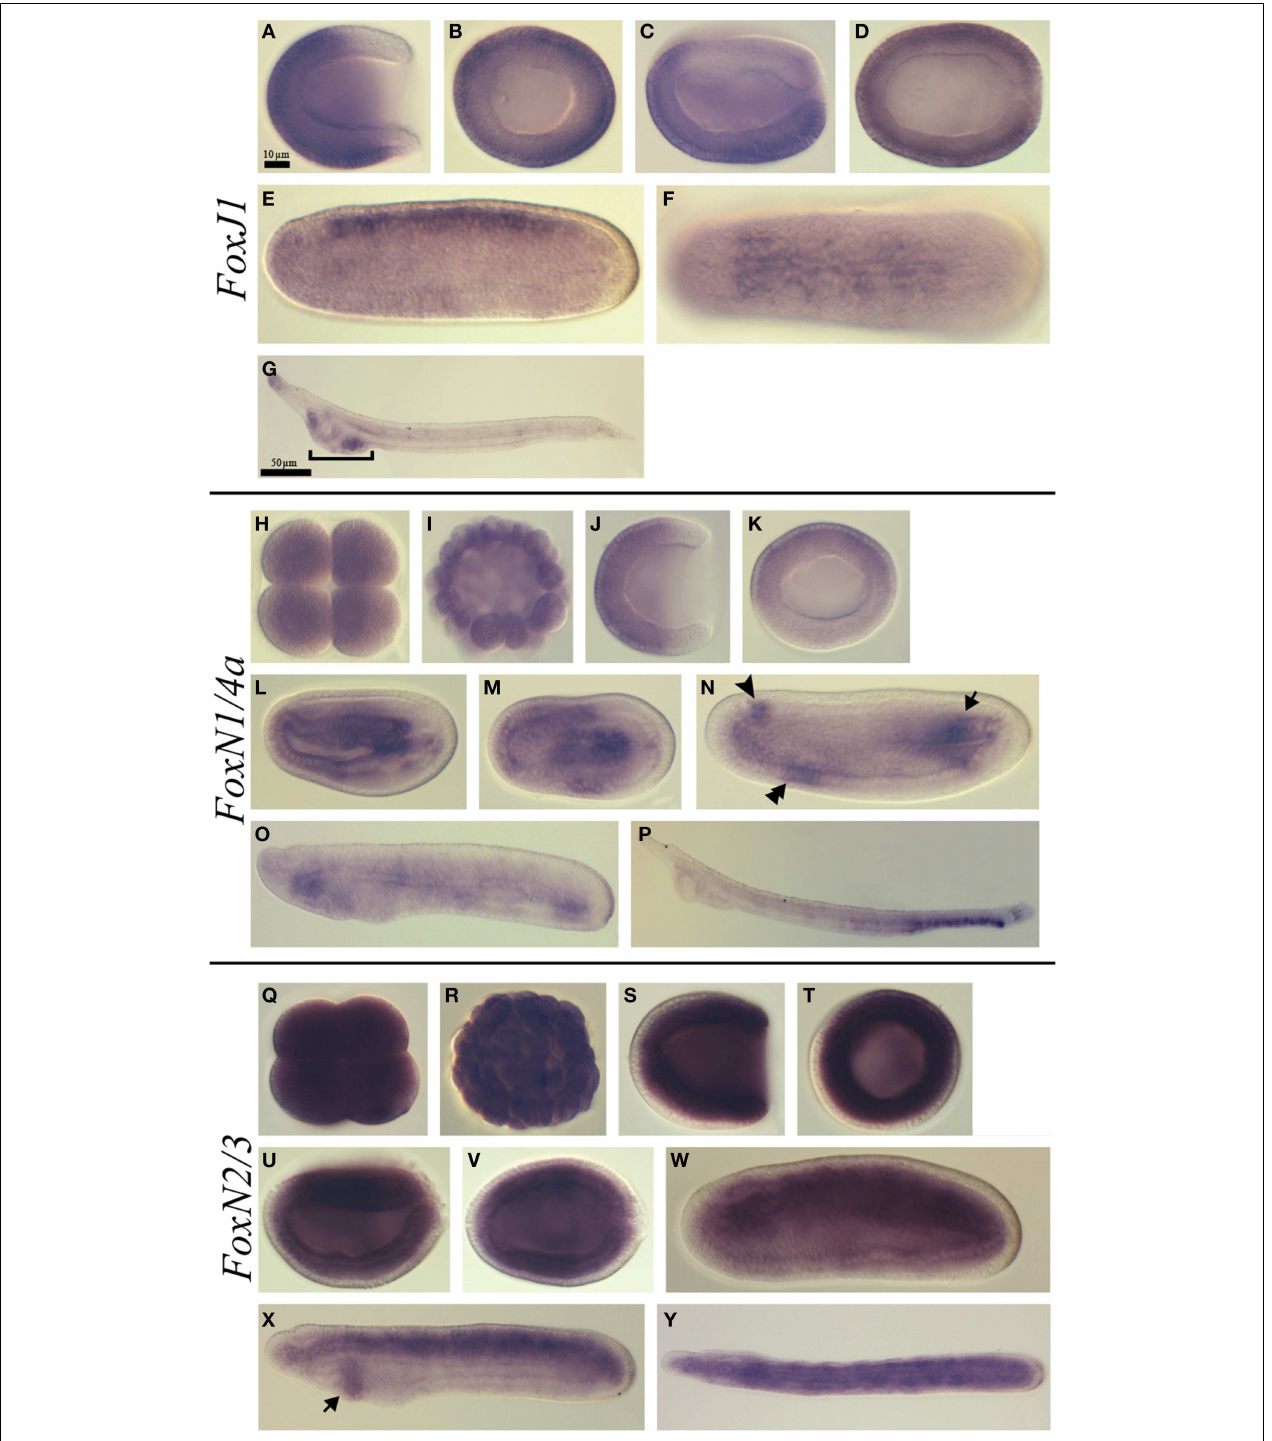
expression pattern (H–P) . Eight-cell stage (H) . Blastula stage (I) . Gastrula lateral (J) and blastoporal views (K) . Early neurula lateral (L) and dorsal (M) views. In the mid-late neurula lateral view (N) , the arrowhead, double arrowhead and arrow mark the three main expression domains: at the level of the cerebral vesicle, in the anterior ventral endoderm and in the posterior (Continued)